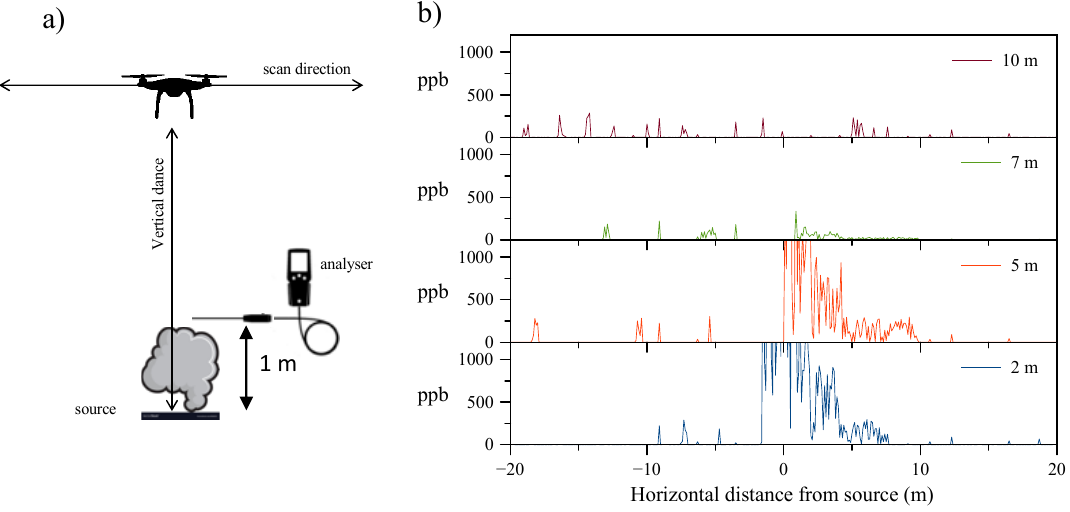
Figure 3. ( a ) Schematic representation of the in-field experimental setup. The analyzer probe was located 1 m above the source. ( b ) Hydrocarbons’ concentration detected by the analyzer during the drone’s scans above the source at various distances.